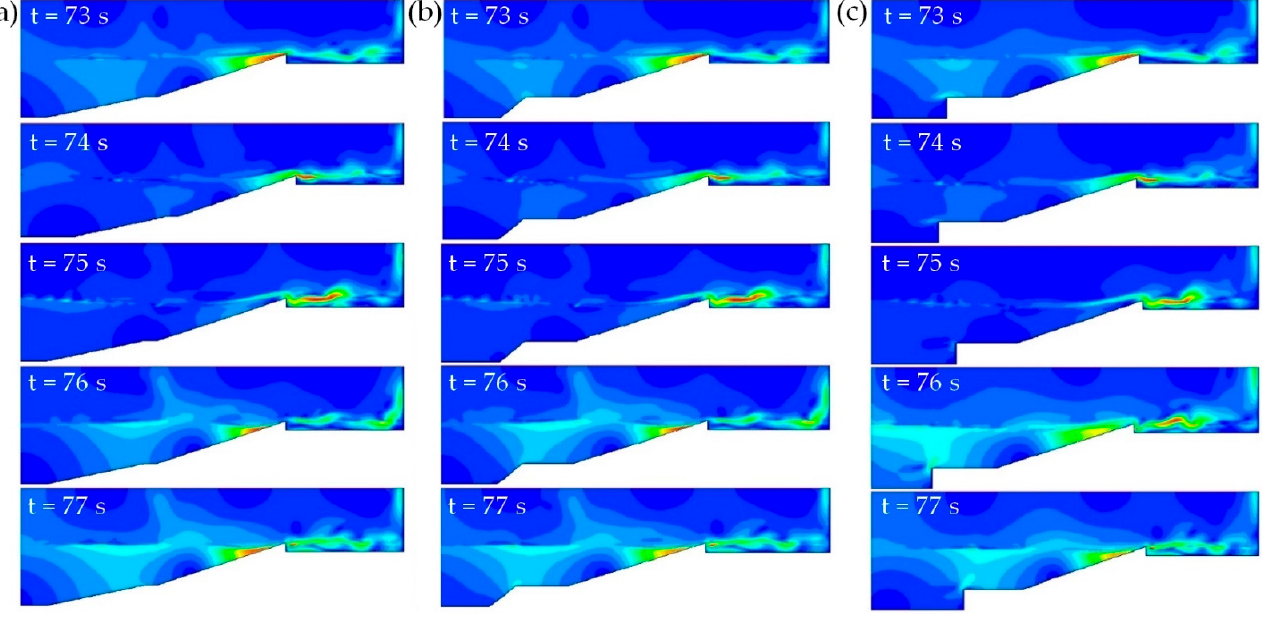
Figure 11. Transient fields of velocity fields for ( H 3 / L 3 ) o = 0.33 and the ratios: ( a ) L 1 / L 2 = 0.11; ( b ) ( L 1 / L 2 ) o = 0.67; and ( c ) L 1 / L 2 = 1.00.